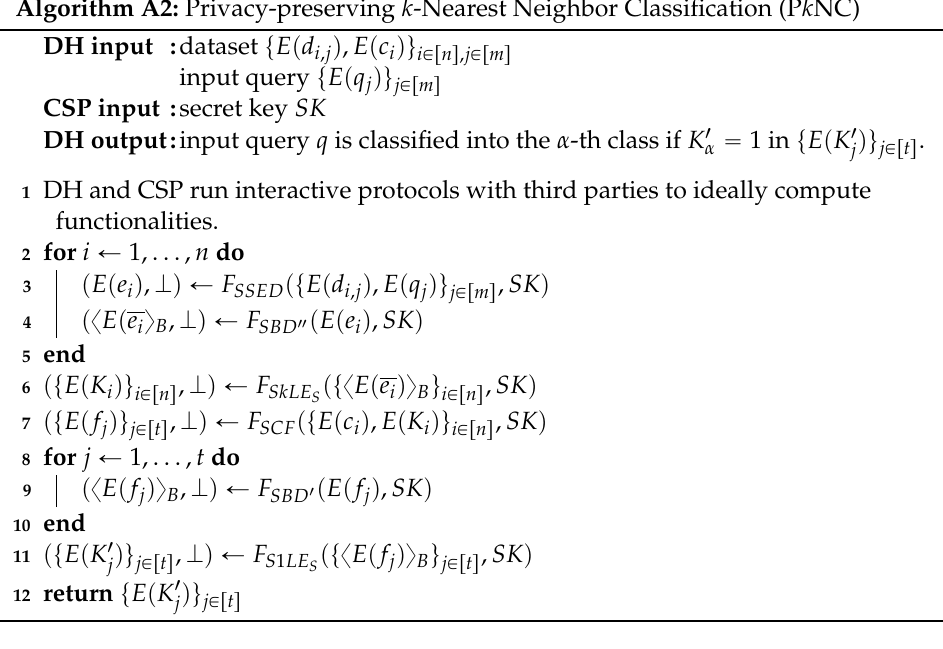
Algorithm A2: Privacy-preserving k -Nearest Neighbor Classification (P k